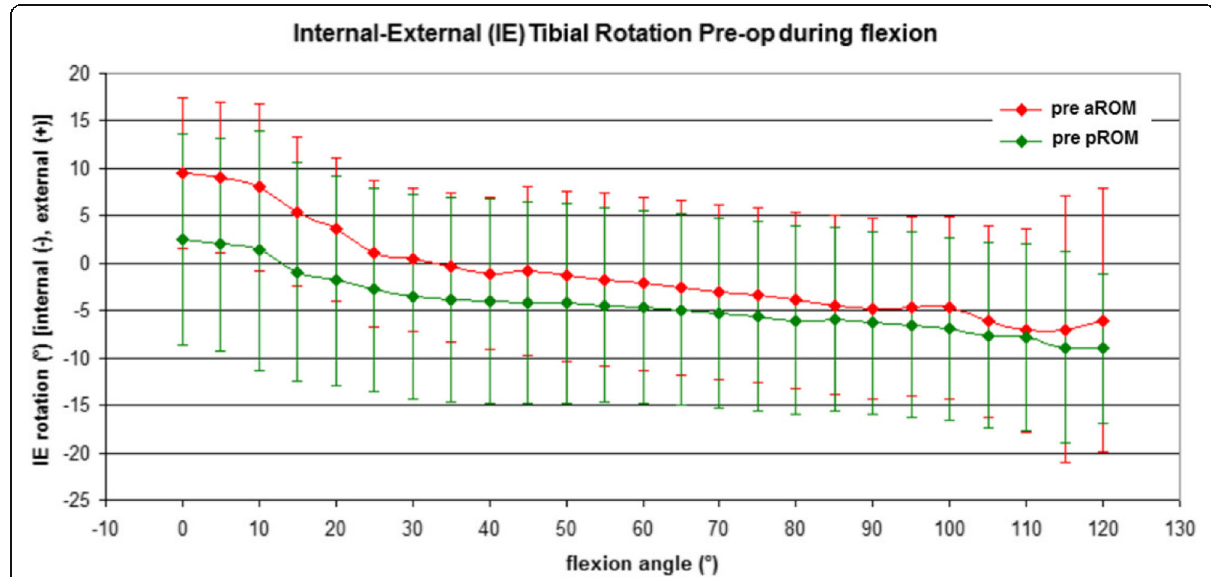
Fig. 3 Pre-operative active and passive internal-external rotation of the femur with respect to the tibia